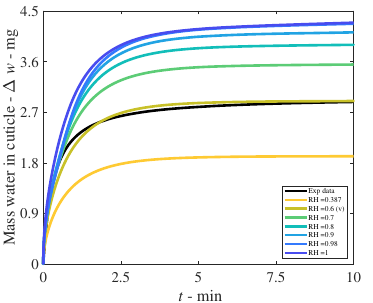
Fig. 2 Validation plot compared to experimental data (Exp data in black) at 60%RH. The 60%RH cuticle model solution (green brown) can be seen corresponding closely to the experiment in black. (v) represents the solution used for validation. The total experimental time here is 10 minutes. We reproduce the experimental data, as described around Supplementary Eq. (1).